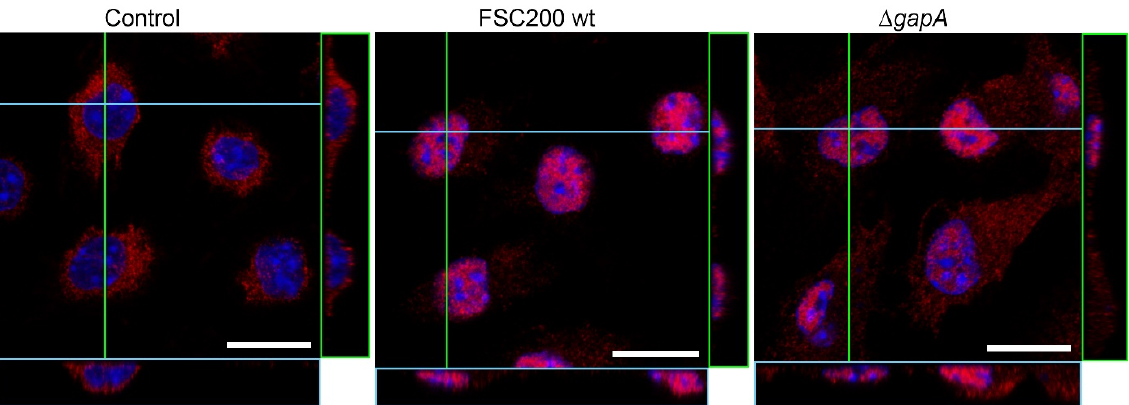
Figure 10. Confocal microscopy of BMDM cells (uninfected—control, or infected either with Δ gapA or wt) stained with Hoechst 33,342 (blue; nuclei) and NF- κ B p65 (red). Each image is one confocal plane with z -axis projections (for blue and green lines) showing the distribution of NF- κ B in the cell, especially the differences of cytoplasm versus nucleus localization. Bar in each image represents 10 µm.